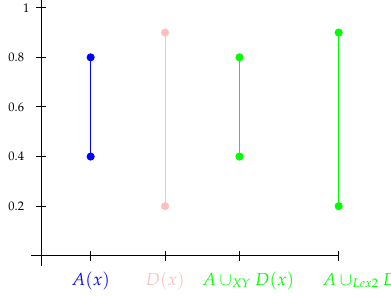
Figure 10. Lex 2-union is different from XY